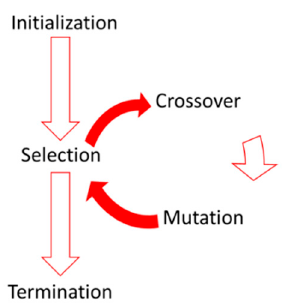
Figure 3. Steps diagram of the genetic algorithm (GA).